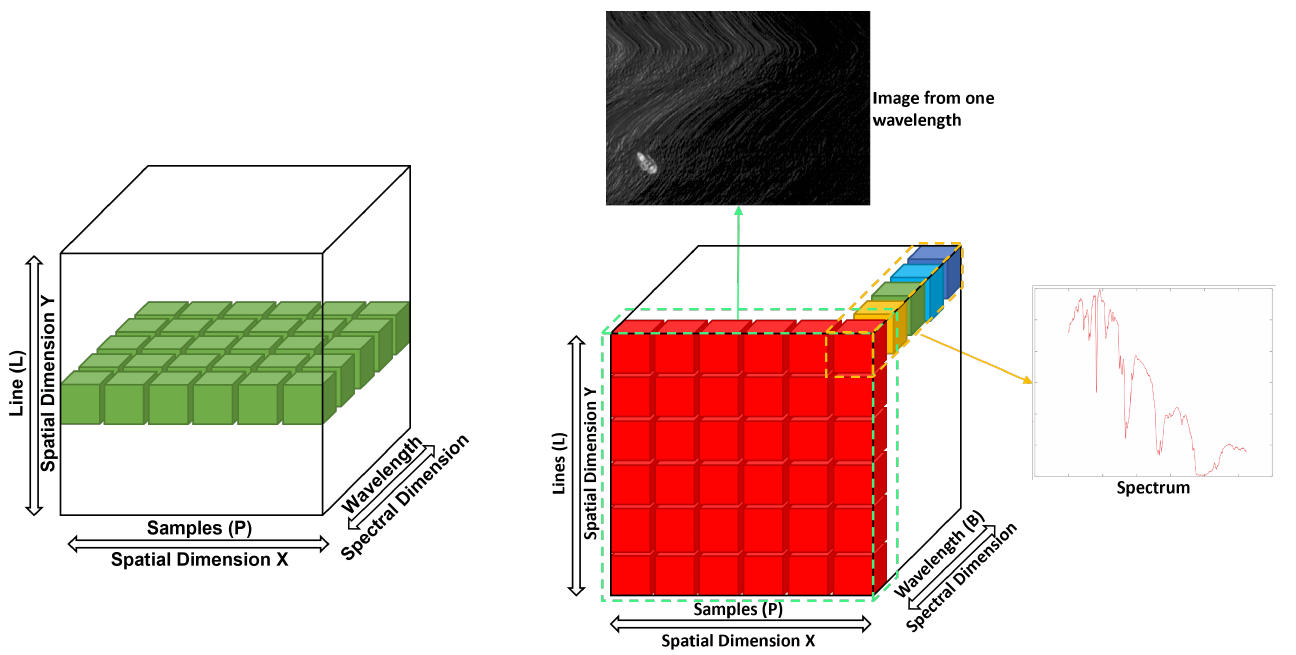
Figure 2. Acquisition scheme for pushbroom hyperspectral cameras: the left image shows the data that are acquired in each frame, in the case of the hyperspectral system, this is denominated as a line, and it is comprised by all the samples (pixels) and all the bands for each pixel in that line. The right image displays the information that is possible to extract from the hyperspectral